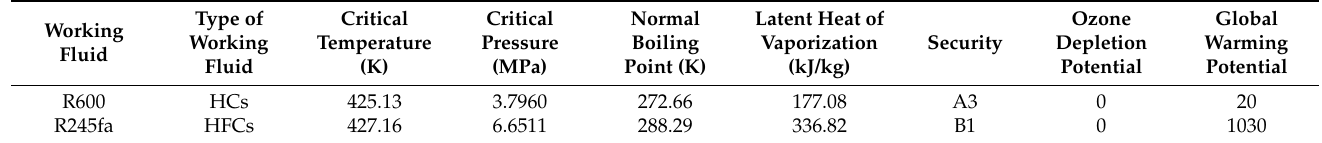
Table 1. Main thermophysical properties and environmental protection parameters of working fluid.